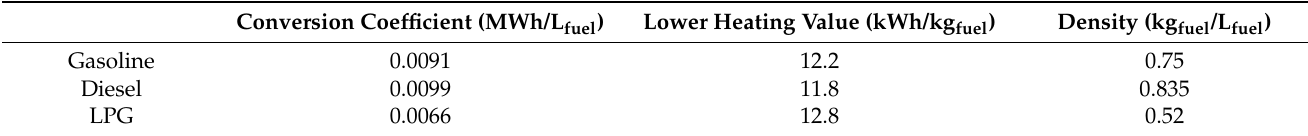
Table 2. Conversion coefficient (MWh/L), lower heating value (kWh/kg) and density (kg/L) for each fuel considered in the model. Conversion Coefficient (MWh/L fuel